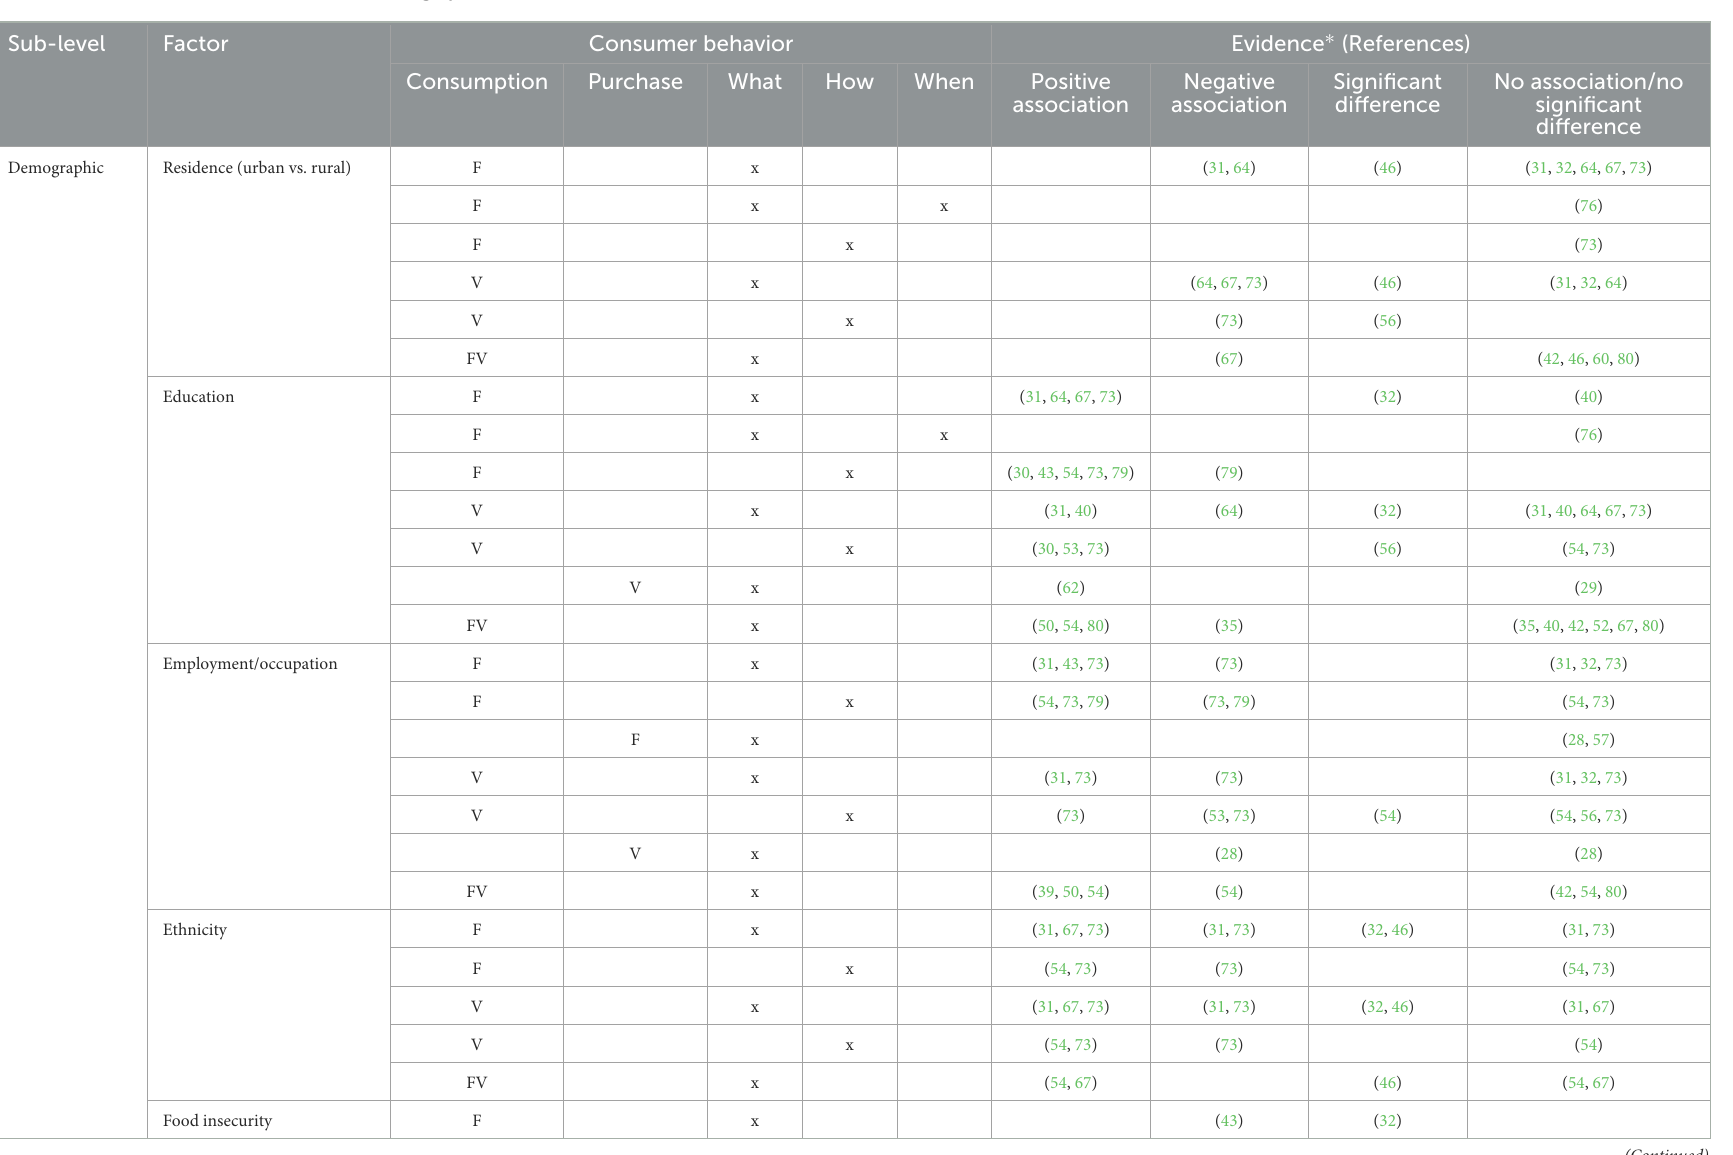
TABLE 2B Individual/household level